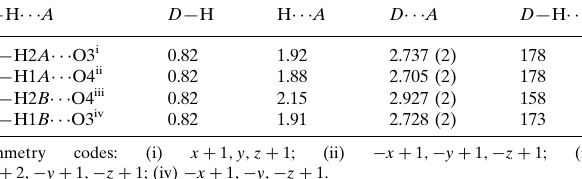
Hydrogen-bond geometry (A˚ , (cid:2)